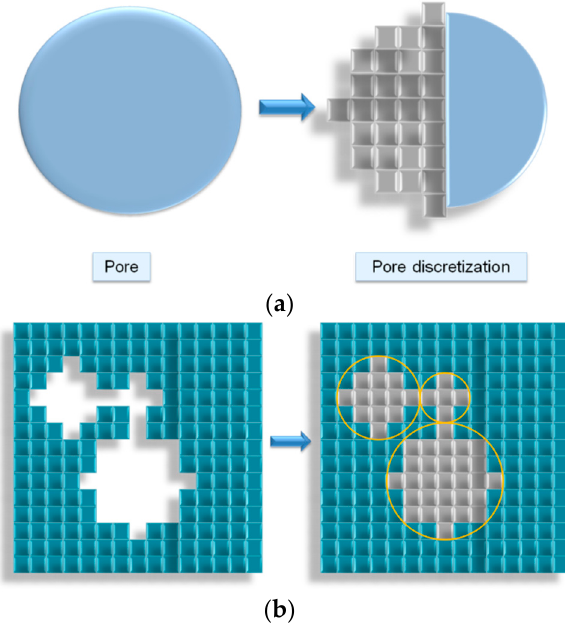
Figure 15. PSD calculation algorithms illustration: ( a ) Cell representation of a pore; ( b ) Placing pores in the form of cells in a digital structure.